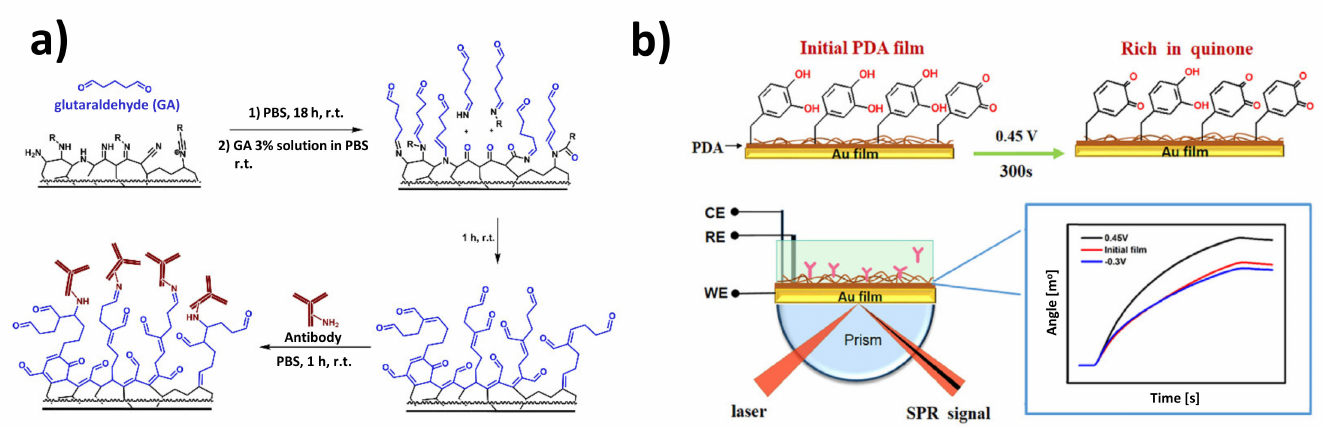
Figure 4. Examples of polymeric interphases employed in SPR immunosensors. ( a ) amine-terminated cyclopropylamine plasma polymer, ( b ) quinone-terminated polydopamine film. Adapted with permission from Makhneva et al. [84] (Copyright © (2018) Elsevier) and Chen et al. [89] (Copyright © (2018)